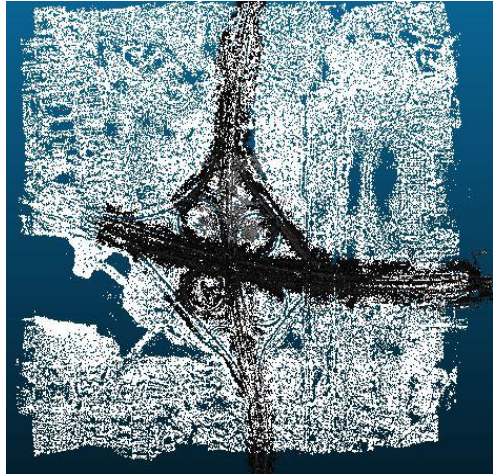
Figure 7. Overlap diagram of LiDAR and 3D feature point.